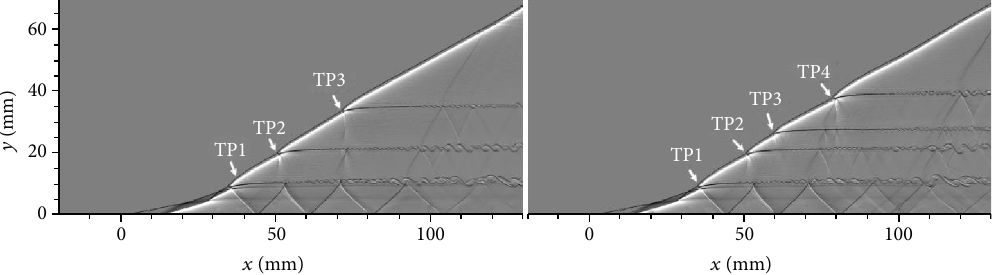
Figure 3: Grid convergence test at θ = 32 ∘ . (a) Undisturbed steady fl ow fi eld for 64 pts/ Δ I and (b) steady fl ow fi eld after UTHD for 64 pts/ Δ I